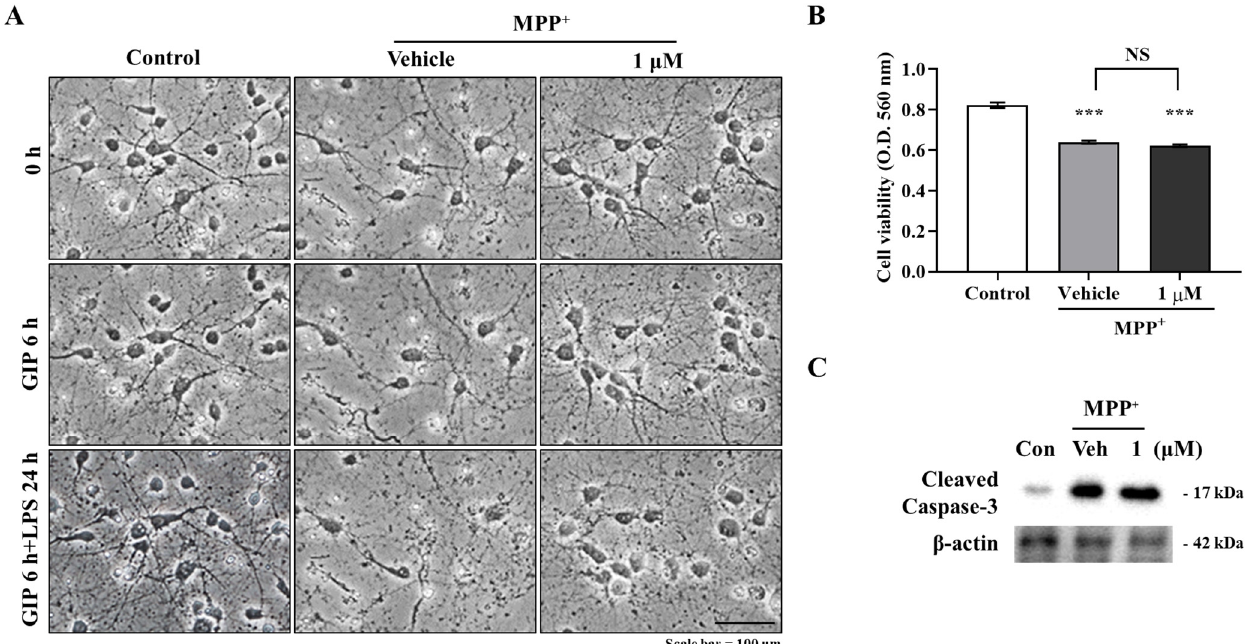
Figure 3. IAGIP had no neuroprotective effect on primary neurons. ( A ) Representative images showing that IAGIP did not protect primary neurons from MPP + -induced neuronal damage. Scale bar = 100 µm. ( B ) MTT assays confirmed that IAGIP did not protect neurons directly. Results are means ± SEs ( n = 4). *** p < 0.001 vs. vehicle-treated controls. ( C ) Western blotting showed that IAGIP did not reduce MPP + -induced caspase-3 cleavage.